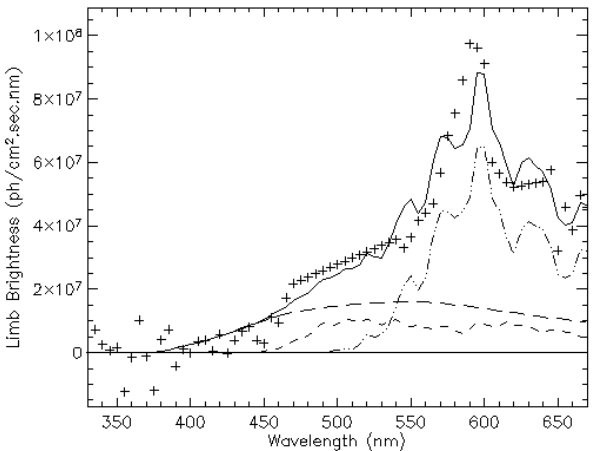
Fig. 6. Least-squares fitting of the chemiluminescent FeO ∗ model spectrum (dot-dot-dash), the NiO ∗ model spectrum (short dash), the chemiluminescent NO ∗ emission (long dash), and the total model 2 spectrum (solid) versus the OSIRIS observed 85km to 90km aver- aged airglow limb “continuum” for June and July of 2003 (+ + +) (panel (C) of Fig. 5), all averaged over 5nm intervals. The ratio of NiO ∗ to FeO ∗ is 0.3 ± 0.1 and NO ∗ to FeO ∗ is 0.6 ± 0.1, integrated 2 over the full spectral range of this